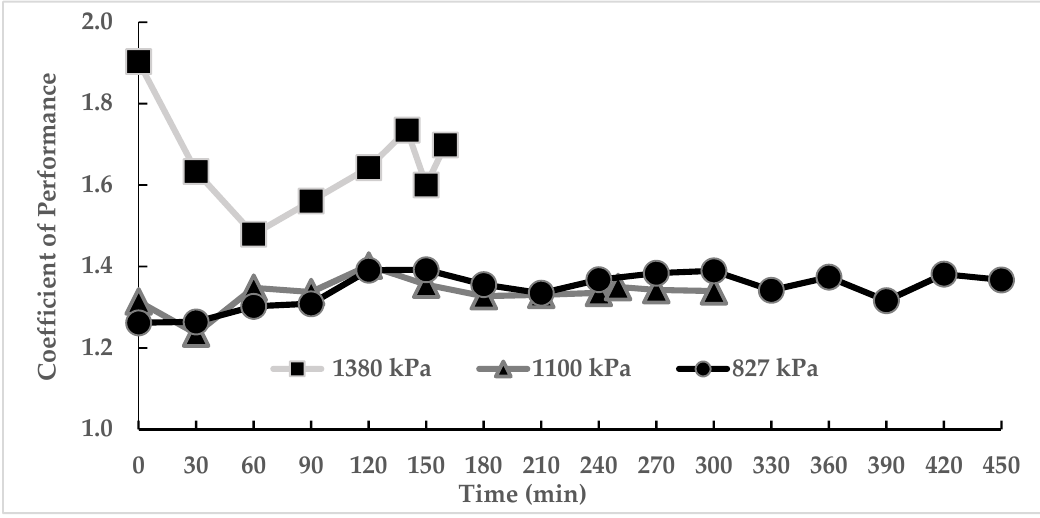
Figure 6. Coefficient of Performance (CoP) for the HPDs in Oregano drying. Figure 6. Coe ffi cient of Performance (CoP) for the HPDs in Oregano drying.